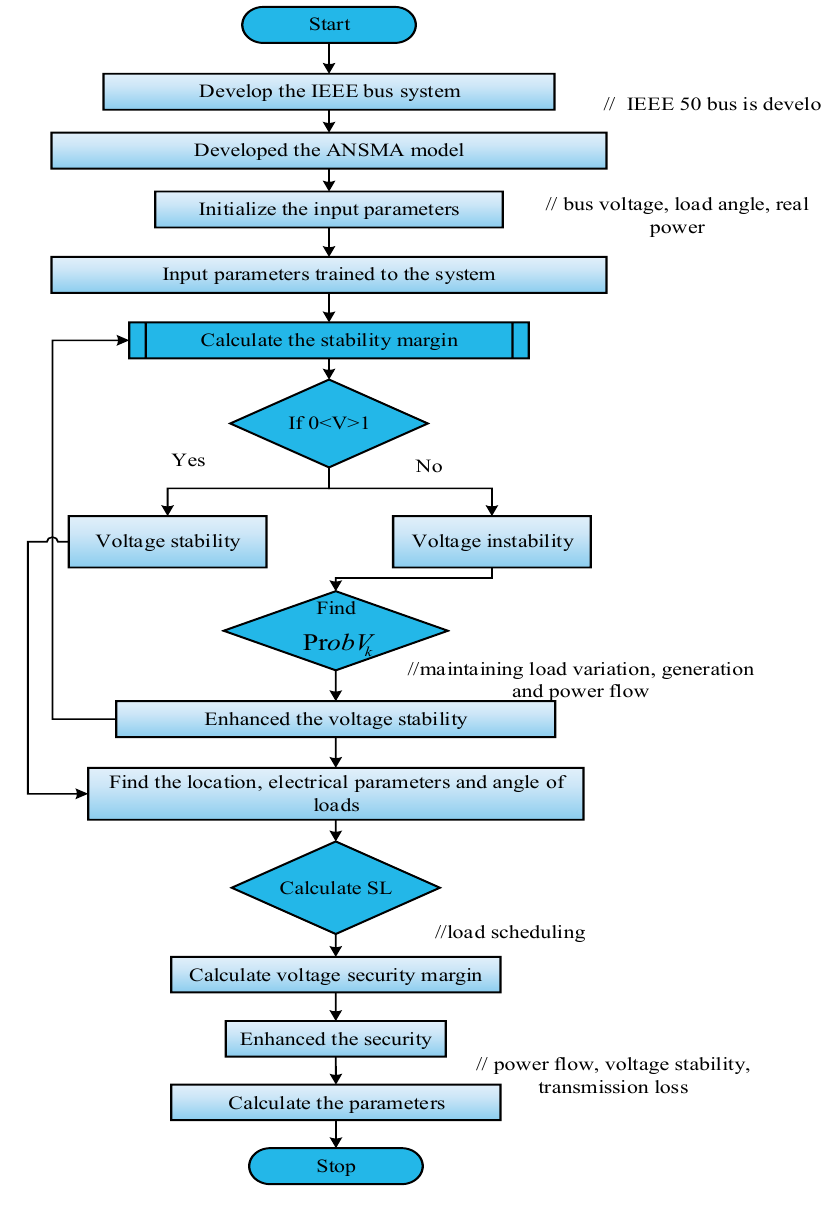
Figure 4. Flowchart representation of the proposed ANSMA